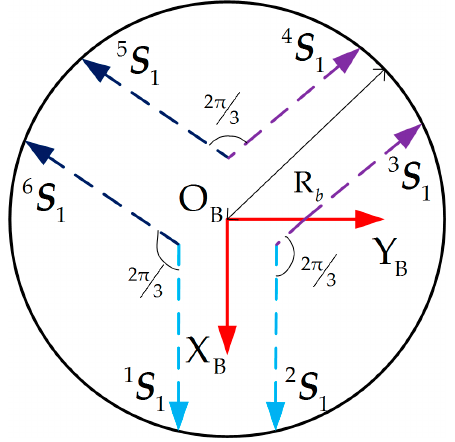
Figure 7. Diagram of equivalent angles.